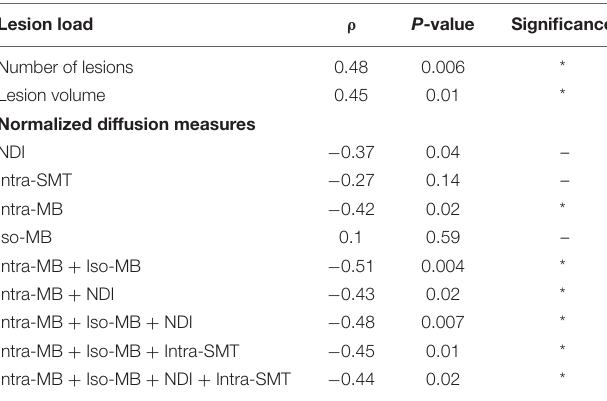
TABLE 4 | Spearman’s correlation of selected normalized diffusion measures, or their combinations and sNfL.